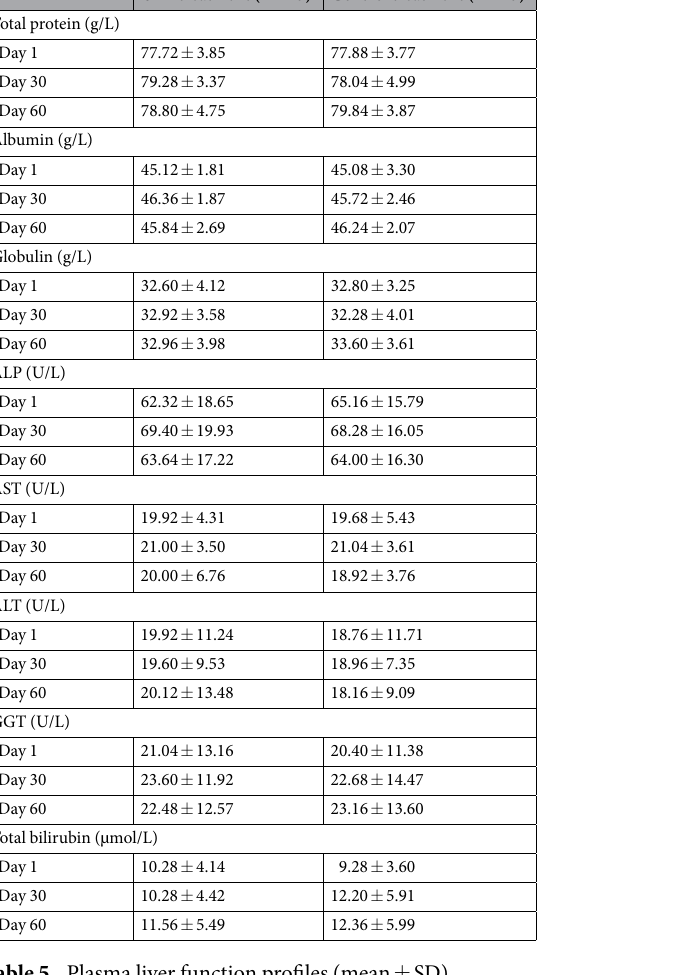
Table 5. Plasma liver function profiles (mean ±